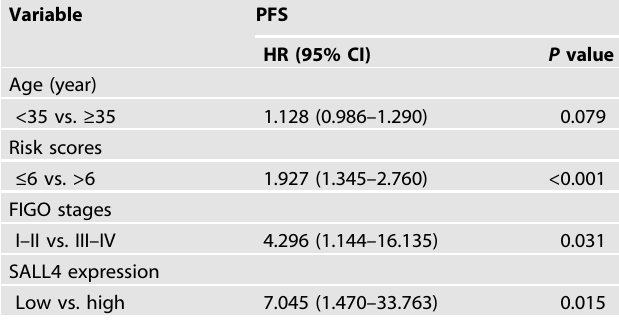
Table 2. Cox regression of SALL4 for progression-free survival (PFS) in